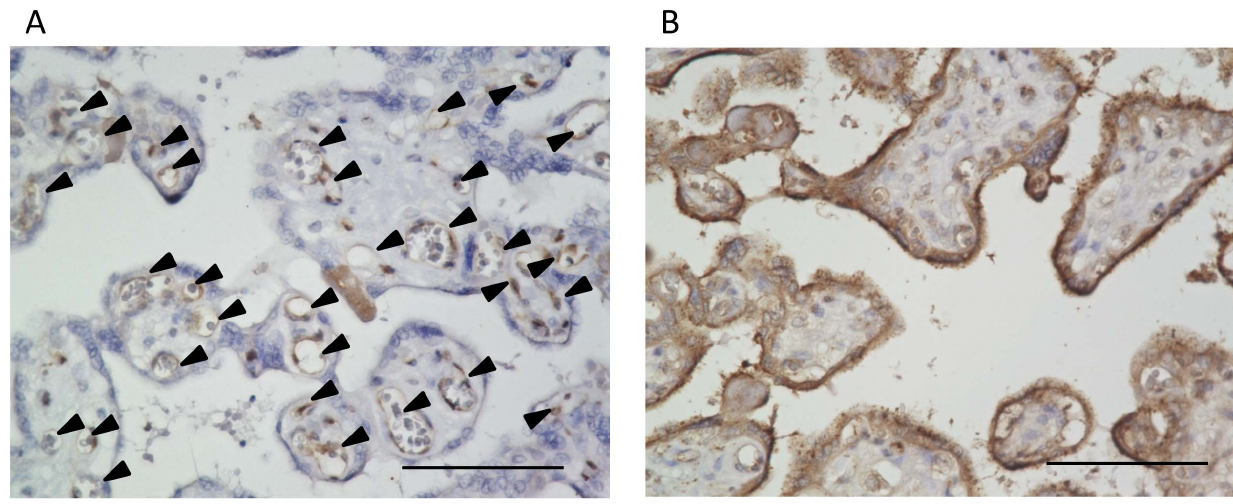
Figure 1. Localization of VASH1 and VASH2 in human placenta. Immunohistochemical analysis for the localization VASH1 (A) and VASH2 (B) in the human placenta was performed. Arrowheads indicate VASH1 vessels (A). Bar=100 m m.